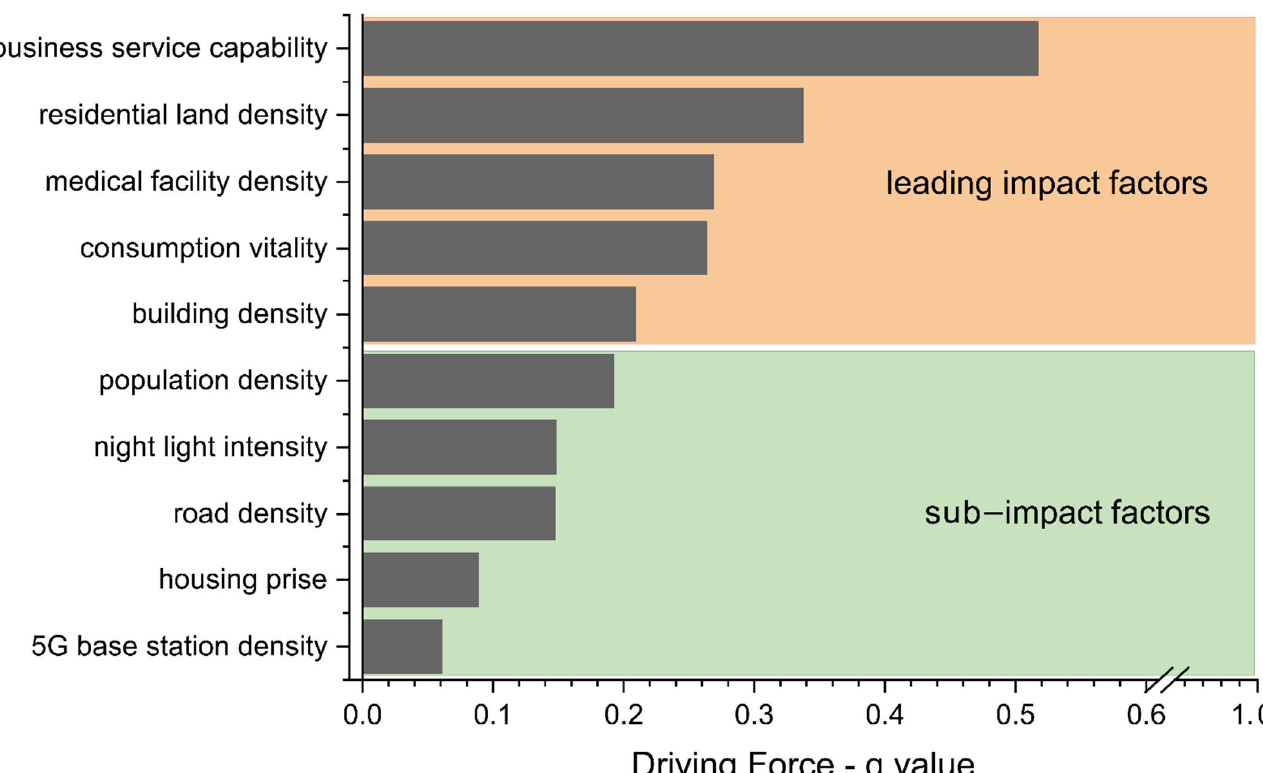
Figure 3. The factor detection results of spatial pattern of unmanned aerial vehicle (UAV) logistics network in Hangzhou.